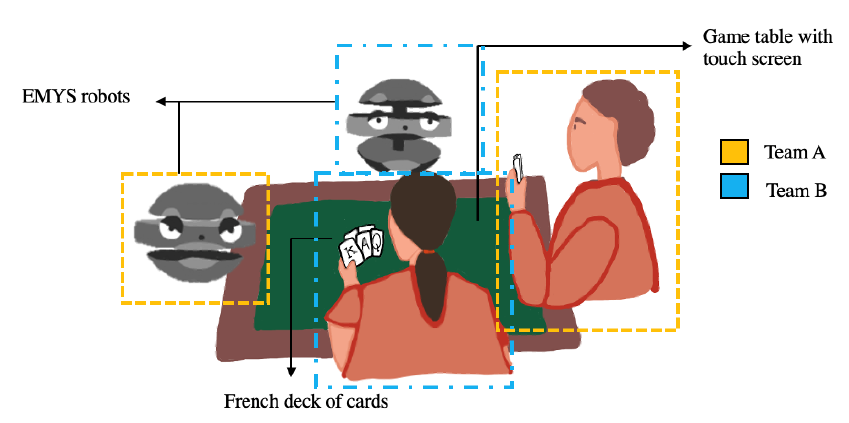
Figure 4. Representation of a scenario involving human-robot interaction in groups based on the work of Oliveira and colleagues [43]. A traditional Portuguese group card-game was implemented for a mixed group of humans and robots. The goal-orientation (collaborative vs. competitive) of robots was manipulated through the utterances they spoke, and the roles (partner vs. opponent) were manipulated through the sitting arrangement of participants (players sitting in front of one another played as partners, whereas players sitting to the sides were opponents). Interactions were recorded and coded according to a coding scheme used for group interactions